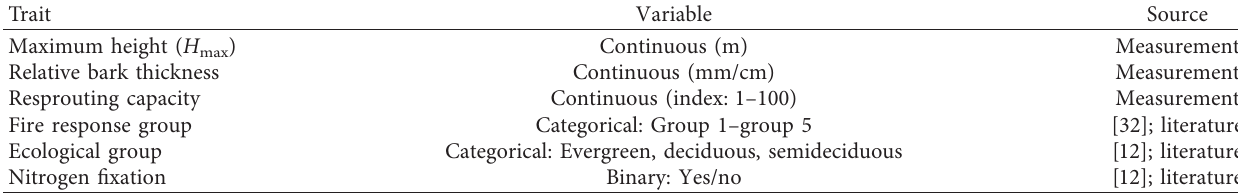
Table 1: List of functional traits derived from measurements in savanna woodlands of Nyanga National Park and from the literature.